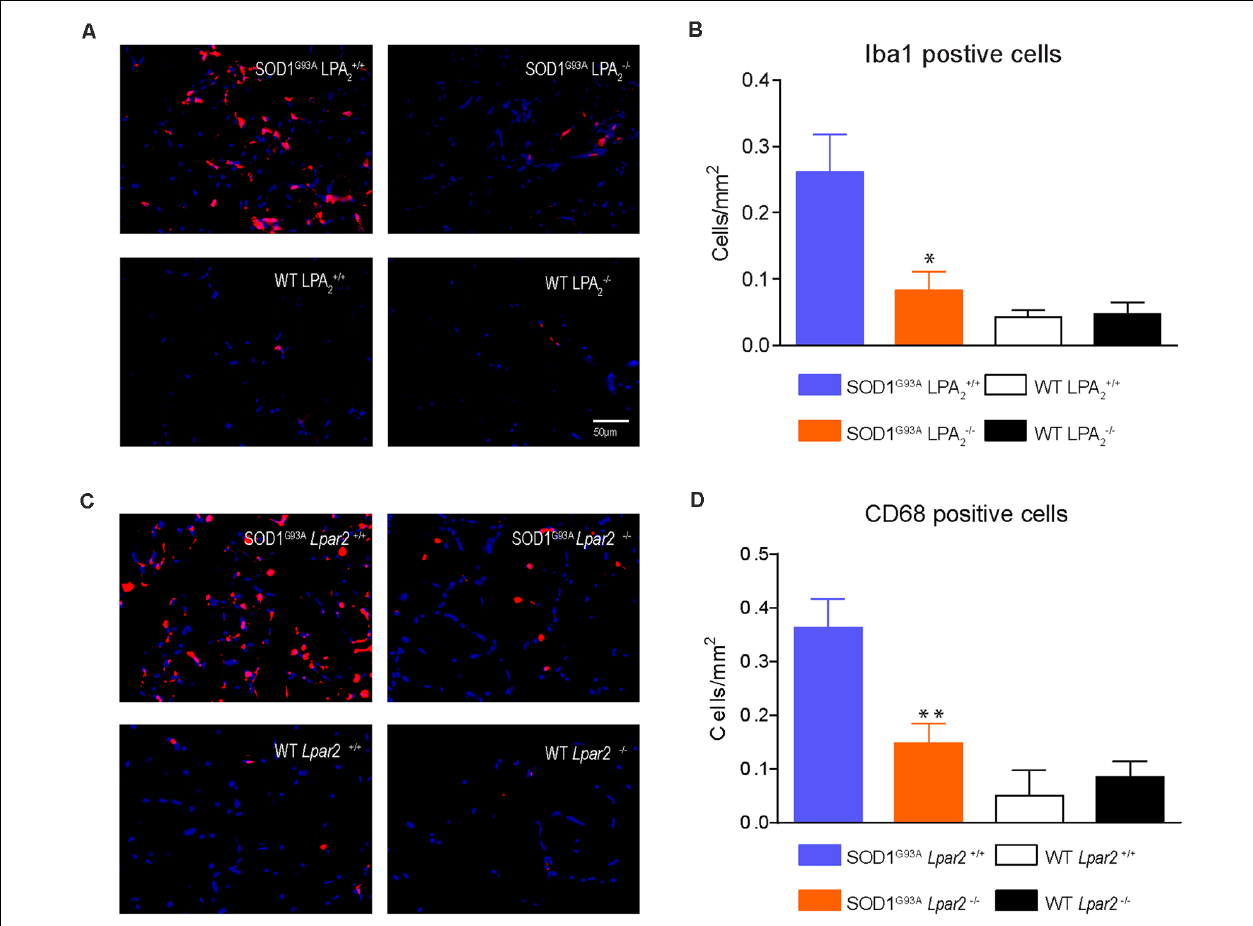
FIGURE 10 | Gene deletion of Lpar2 reduces macrophage invasion in the muscle of ALS mice. (A) Representative images of gastrocnemius muscle cross tissue sections stained against Iba1. (B) Plot showing the quantification of the Iba1+ cells. (C) Representative images of gastrocnemius muscle cross tissue sections stained against CD68. (D) Plot showing the quantification of the CD68+ cells. n = 4 per group. One-way ANOVA with Bonferroni’s post hoc test. ∗ p < 0.05, ∗∗ p < 0.01 vs. SOD1 G93A Lpar2 +/+ . Data are presented as mean ±